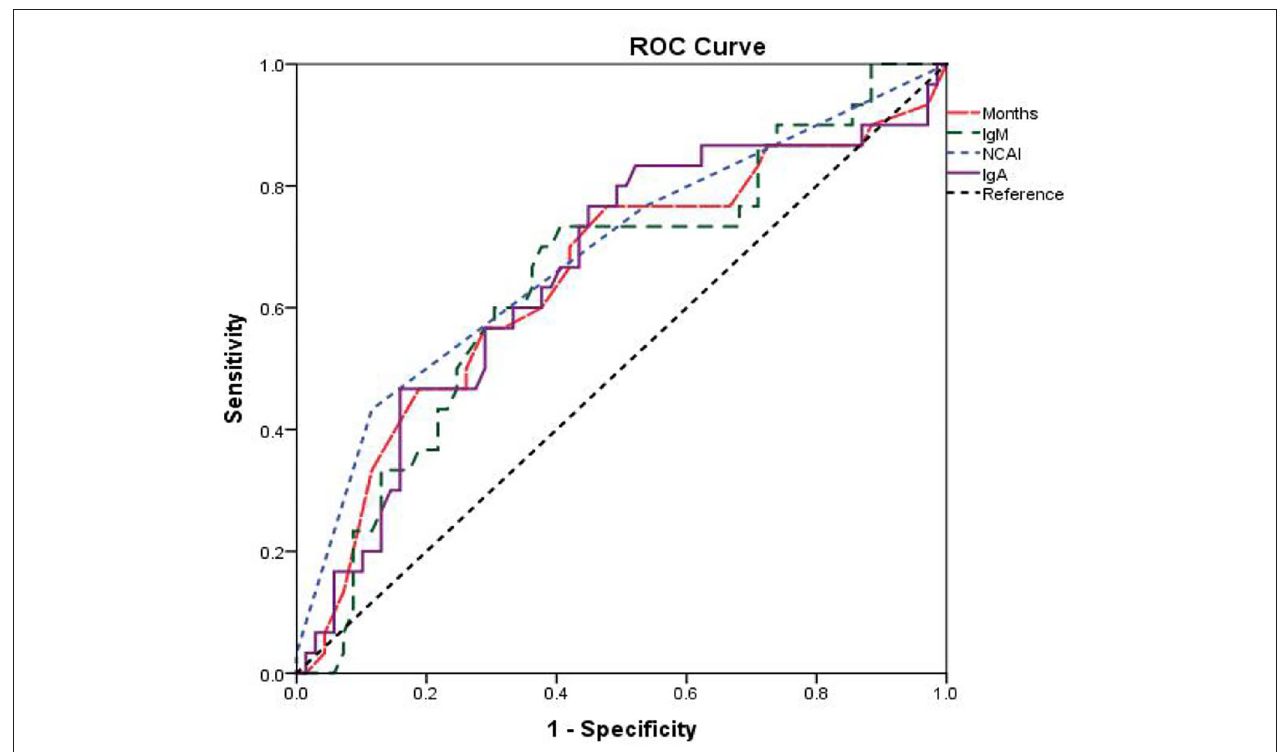
FIGURE 3 | The ROC curve of age, IgM, IgA, and NCAI independently predicts CALs.